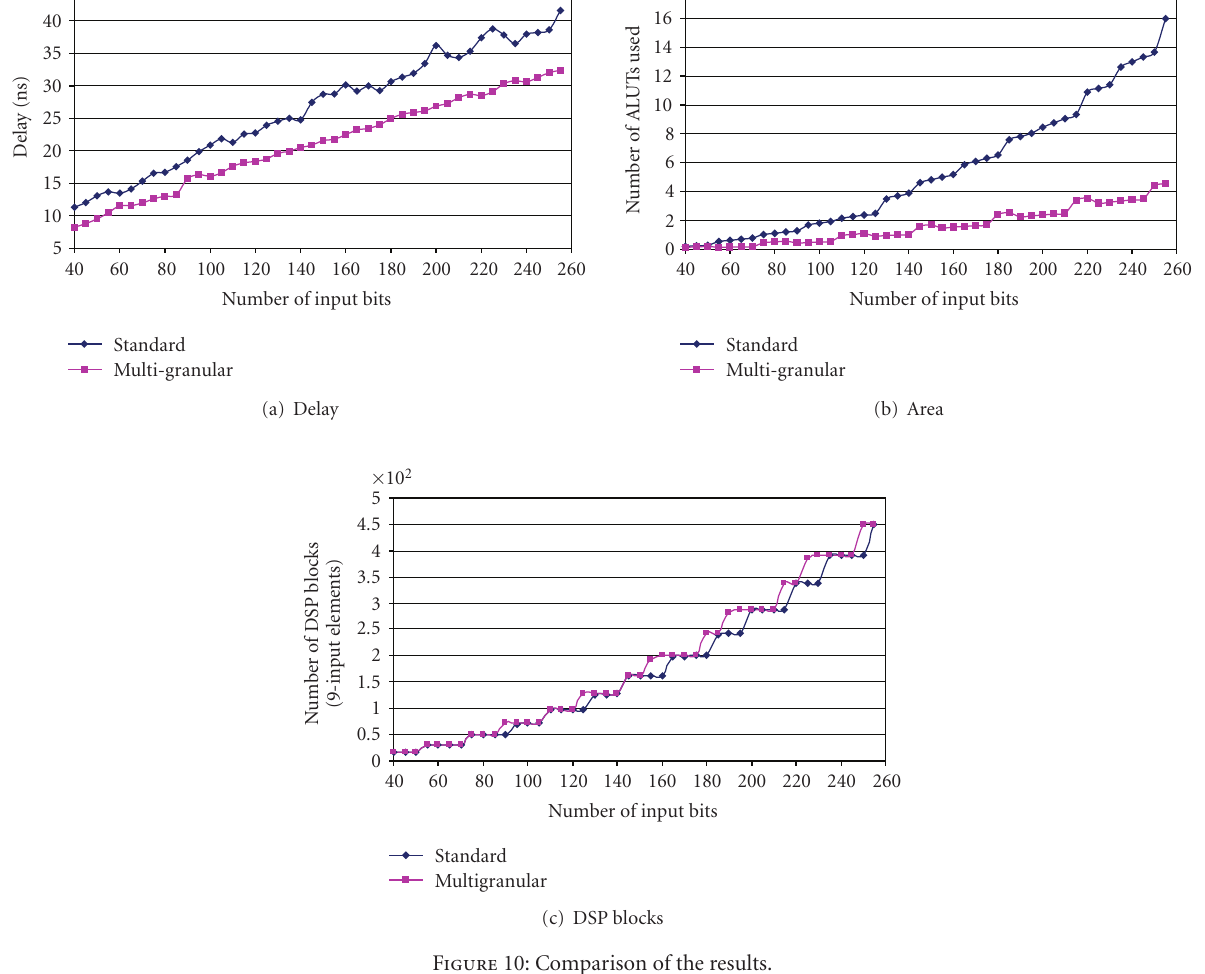
Figure 10: Comparison of the results.